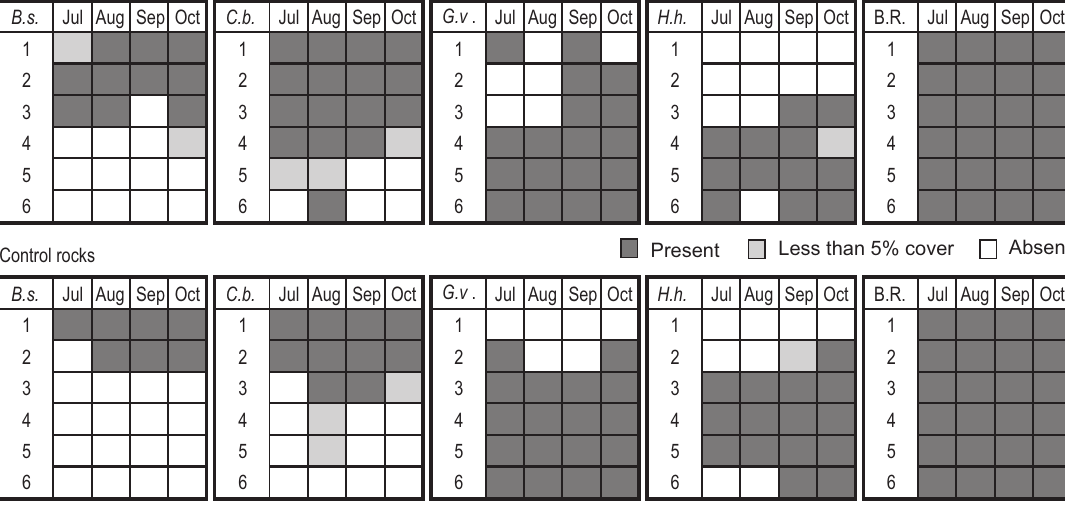
Figure 1. Occurrence of four sessile species on permanent quadrats (100 cm 2 ) along a vertical gradient (1 = higher and 6 = lower, close to